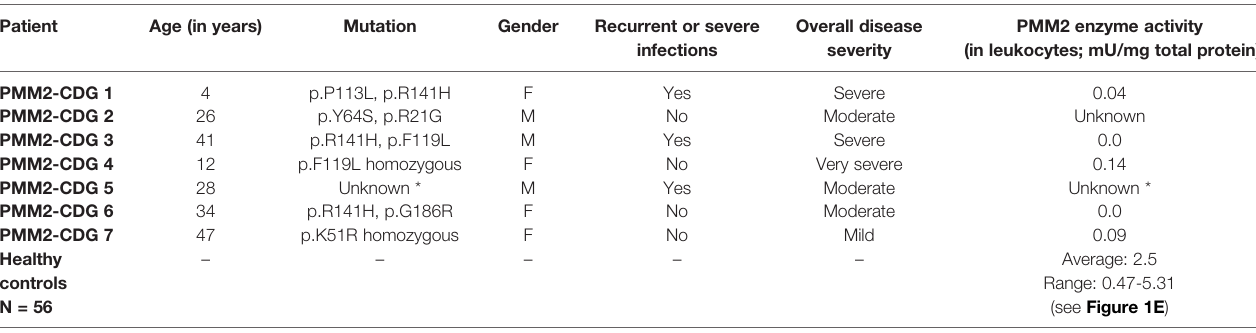
TABLE 1 | PMM2-CDG patient